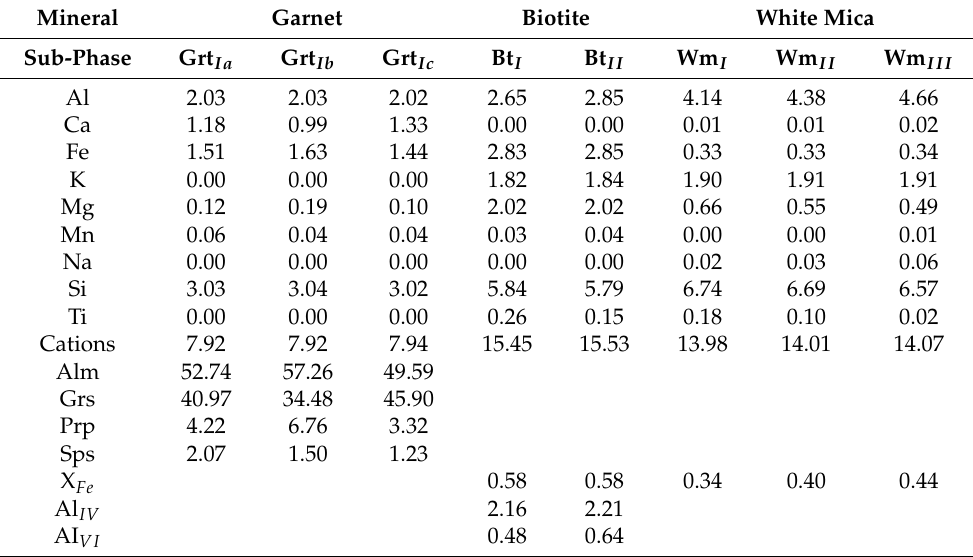
Table 2. Average compositions of minerals from Lago della Vecchia obtained via Q-XRMA. All values are calculated on the base of 605 calibrated pixels for Grt Ia ; 1412 calibrated pixels for Grt Ib and 7454 calibrated pixels for Grt Ic ; 8006 calibrated pixels for Bt I and 6782 calibrated pixels for Bt II ; 735 calibrated pixels for Wm I ; 8169 calibrated pixels for Wm II and 15,118 calibrated pixels for Wm III . Alm = Fe/(Fe + Mg + Ca + Mn), Grs = Ca/(Fe + Mg + Ca + Mn), Prp = Mg/(Fe + Mg + Ca + Mn), Sps = Fe/(Fe + Mg + Ca + Mn). Mineral Garnet